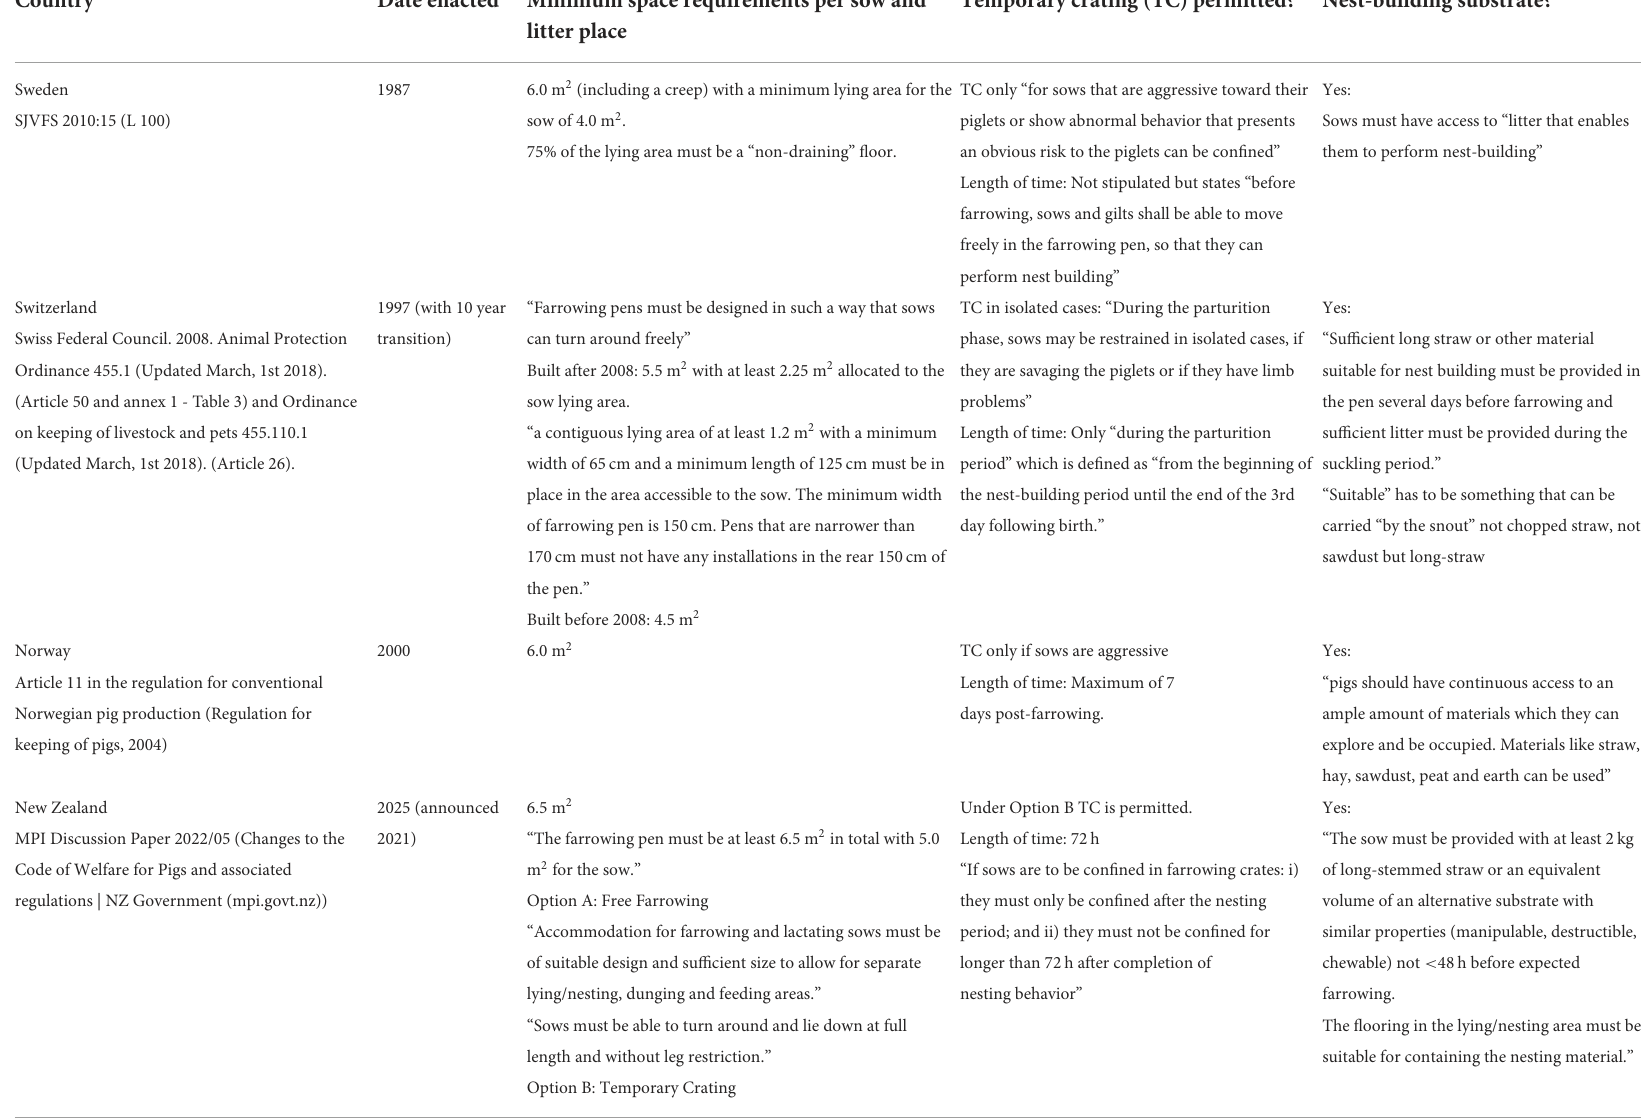
TABLE 1 Regulations for minimum farrowing and lactation standards in countries restricting farrowing crate